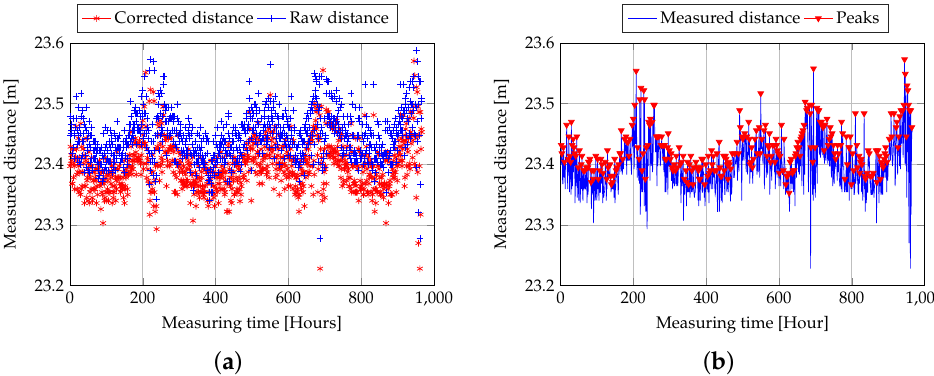
Figure 9. Experimental distance measurement between two stable nodes at a distance of 23.4 m: ( a ) corrected distance measurement considering average variation and ( b ) measurement